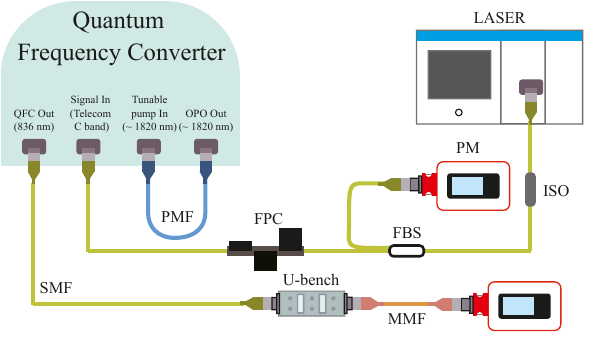
Figure 2: Schematic diagram of the optical setup for QFC performance test at the high input power regime. FPC: fiber polarization controller, PM: power meter, ISO: isolator, FBS: fiber beam splitter, U-bench: U-bench with band-pass filters, SMF: single-mode fiber, PMF: polarization-maintaining fiber, MMF: multi-mode fiber.